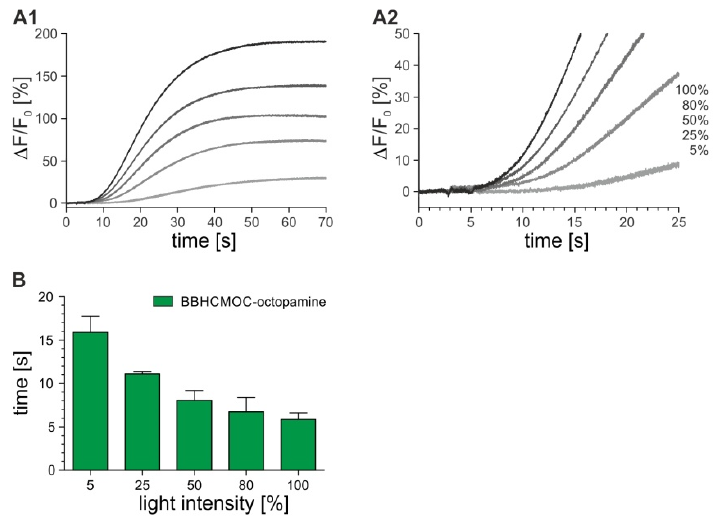
Figure 7. BBHCMOC-octopamine photolysis for activation of the DmOct β 1 receptor in flpTM-DmOct β 1 cells. ( A1 ) flpTM-DmOct β 1 cells loaded with Fluo-4 were mixed in the cuvette of a stopped-flow system with a final concentration of 10 µM BBHCMOC-octopamine. After 2 s incubation a 50 ms UV-flash (405 nm) was triggered and fluorescence intensity was recorded for 70 s; ( A2 ) Measurements were repeated applying different light intensities (5%–100%). The time point of triggering the light flash was defined as t = 0. The first 25 s of the reaction were plotted. A representative measurement from two independent datasets is shown; ( B ) Signal response times ± SD obtained from two independent measurements were plotted against light intensities (%).